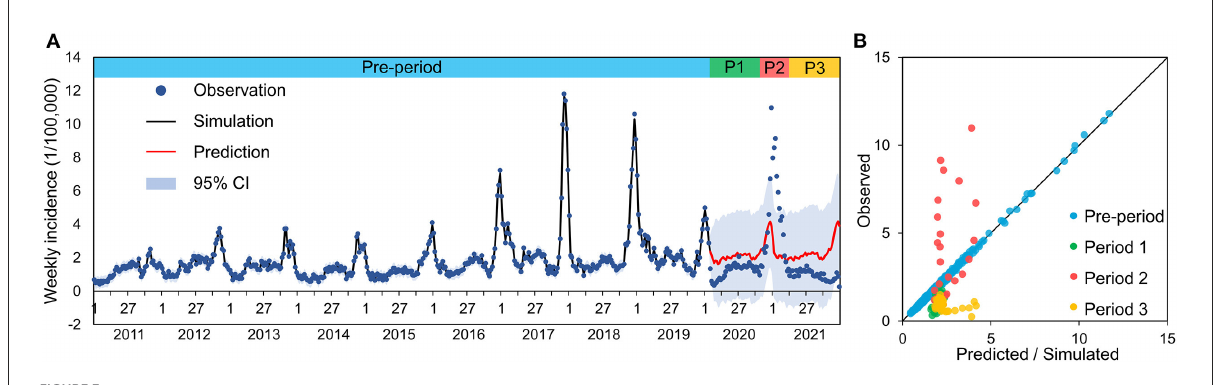
FIGURE3 Observed incidence and predicted incidence (Bayesian structural time series model) of infectious diarrhea in Xi’an (A) and differences between predicted and observed values during different periods (B)